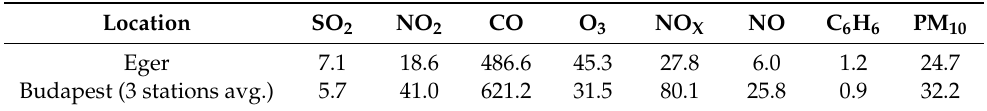
Table 1. Average daily concentrations of air pollutants in Eger and Budapest, measured from 2012 to 2020 and expressed in µ g / m 3